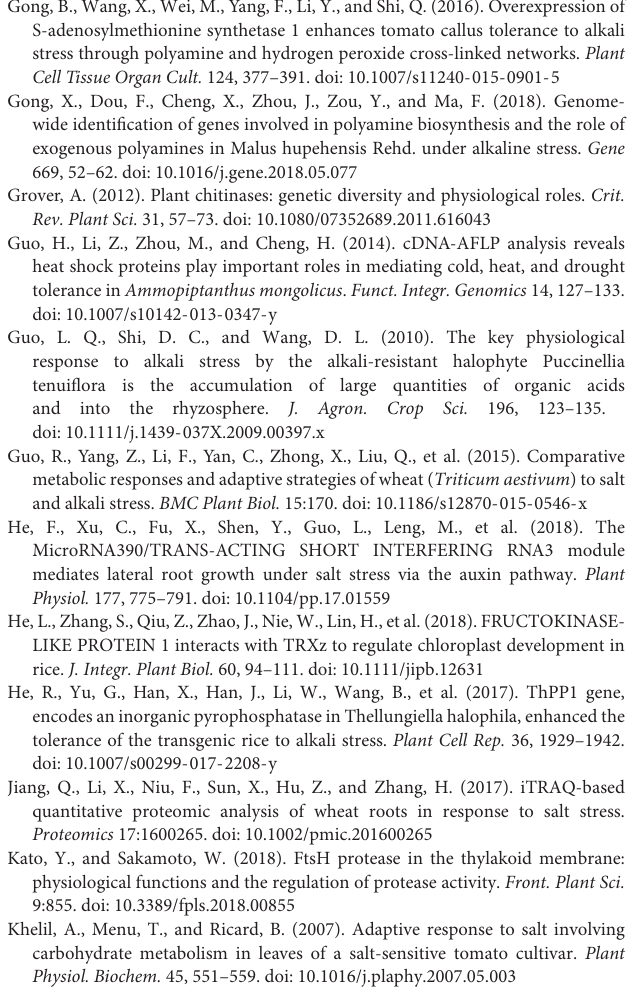
Supplementary Figure 1 | Effects of spermine on the MDA contents and SOD, POD, CAT activities under alkali stress. SOD, superoxide dismutase; POD, peroxidase; CAT, catalase; MDA, malondialdehyde; CK, control; AS, alkali stress (35 mmol.L − 1 Na 2 CO 3 :NaHCO 3 ( =1:1),; AS ( +Spm:, 35 mmol.L(-1 Na2CO3NaCO3:NaHCO3(1:1) ( +0.01 mmol.L(1L-1 spermine. Supplementary Figure 2 | Effects of alkali stress on total flavone contents in leaves. Supplementary Figure 3 | Western blot analysis. (A) The expression levels of coproporphyrinogen III oxidase, protoporphyrinogen oxidase, ATP-dependent zinc metalloprotease FTSH 8, cytochrome f of leaves (L) at AS were normalized to CK. (B) The expression levels of cytochrome f and photosystem II 10 kDa polypeptide of leaves (L) at AS + Spm were normalized to AS. (C) The expression level of profilin of roots (R) at AS was normalized to CK. (D) The expression levels of glucan endo-1,3-beta-glucosidase, polyphenol oxidase of roots (R) at AS + Spm were normalized to AS. The results were presented as mean ± SD ( n = 3). ∗ p < 0.05, ∗∗ p < 0.01. CK, control; AS, alkali stress (35 mmol.L − 1 Na 2 CO 3 :NaHCO 3 = 1:1); AS + Spm, alkali stress + spermine (35 mmol.L − 1 Na 2 CO 3 :NaHCO 3 + 0.01 mmol.L − 1 spermine); R, roots; L, leaves. Supplementary Figure 4 | (A) GO and (B) KEGG analysis of differentially expressed proteins in roots at CK vs. AS. The color gradient indicated significance, ∗∗∗ indicated P < 0.001, ∗∗ indicated P < 0.01, ∗ indicated P < 0.05. CK, control; AS, alkali stress (35 mmol.L − 1 Na 2 CO 3 :NaHCO 3 = 1:1).